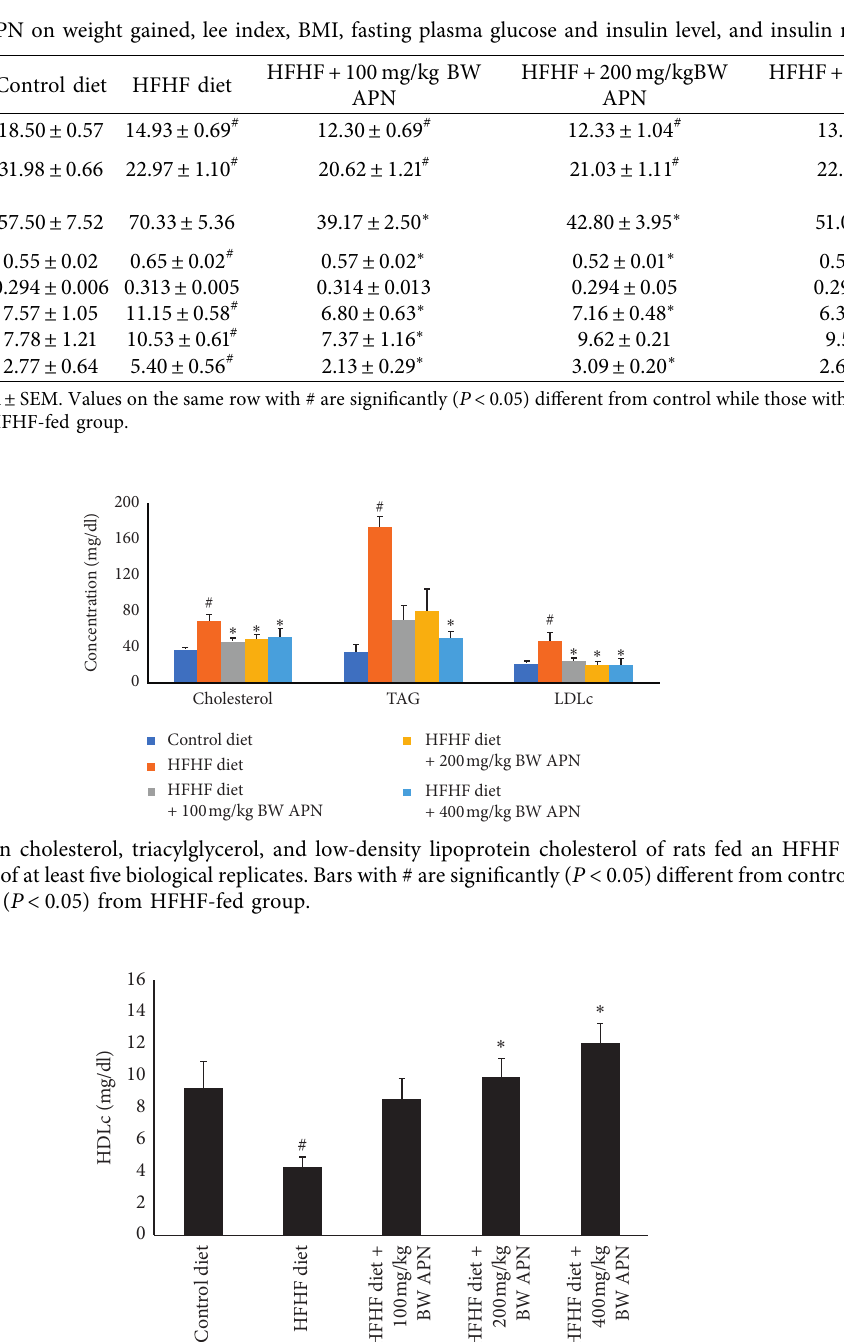
Figure 2: Effect of APN on HDLc of rats fed an HFHF diet. Values are represented as mean ± SEM of at least five biological replicates. Bars with # are significantly ( P < 0 . 05) different from control while bars with ∗ are significantly different ( P < 0 . 05) from HFHF-fed group.